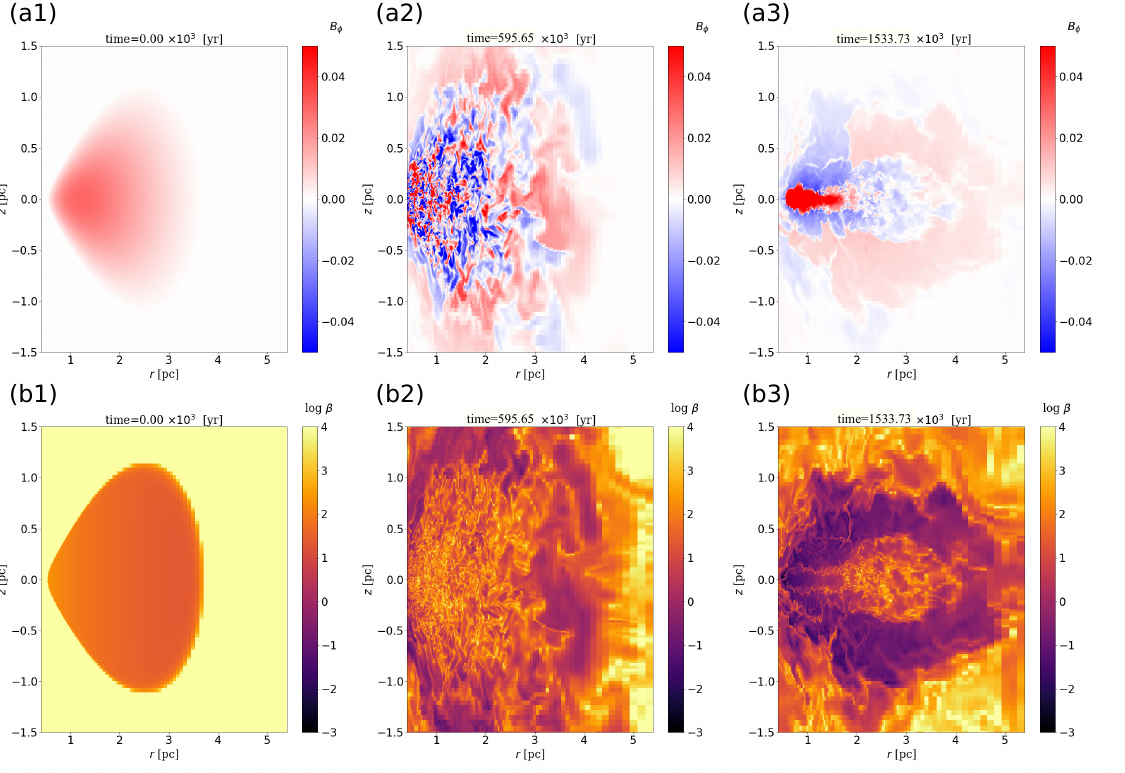
Figure 2. The same of time snapshots as Figure 1 but for the distribution of B ϕ ( top panels ) and plasma β ( bottom panels